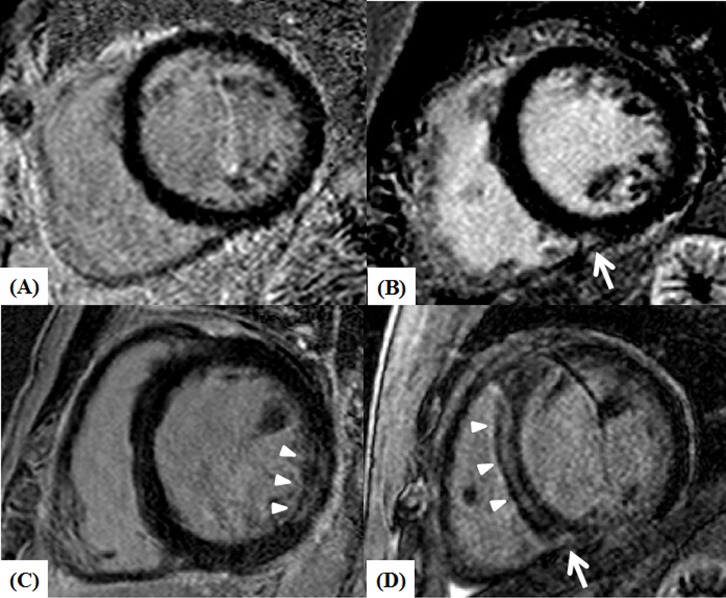
Left ventricle short-axis CMR images of NICM patients showing no LGE (A), patchy LGE confined to the inferior RV insertion area (B, white arrow), midwall LGE at the inferolateral wall of LV (C, arrow heads), and LGE at the midwall of septum (arrow heads) and inferior RV insertion area (white arrow) (D). CMR: cardiac magnetic resonance; NICM: non-ischemic dilated cardiomyopathy; LGE: late gadolinium enhancement; RV: right ventricular.